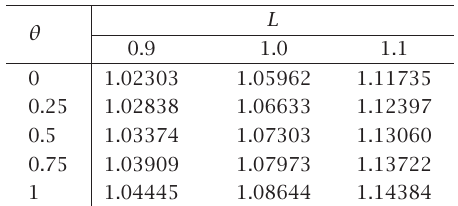
Table 4.1 . Cost of bivariate portfolio insurance.